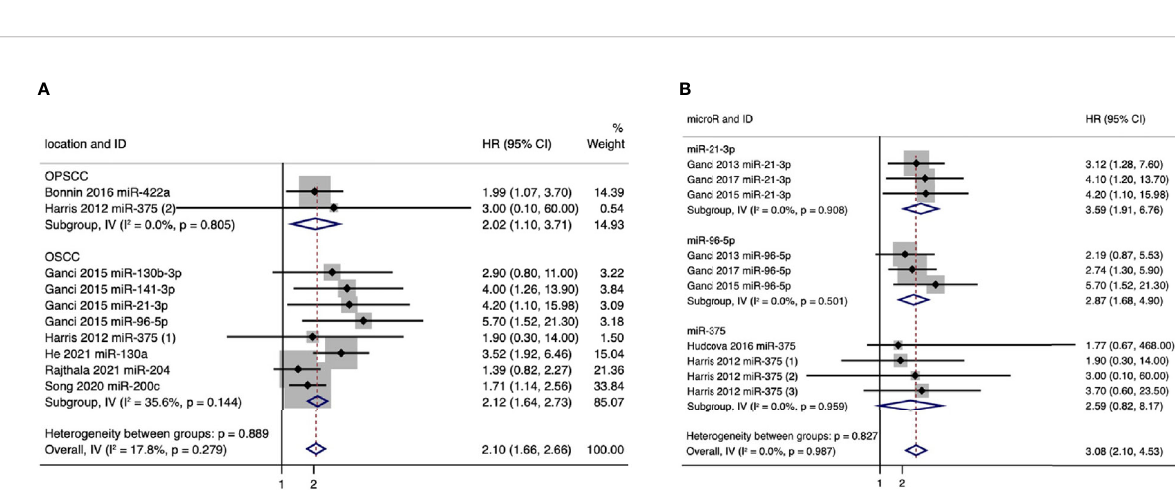
FIGURE 3 | (A) Forest plot for subgroup analysis of the association between microRNA expression and recurrence-free survival (RFS) based on anatomical subsites. (B) Forest plot for subgroup analysis of the association between microRNA expression and recurrence-free survival (RFS) based on microRNAs (only individual microRNAs with more than two outcomes were